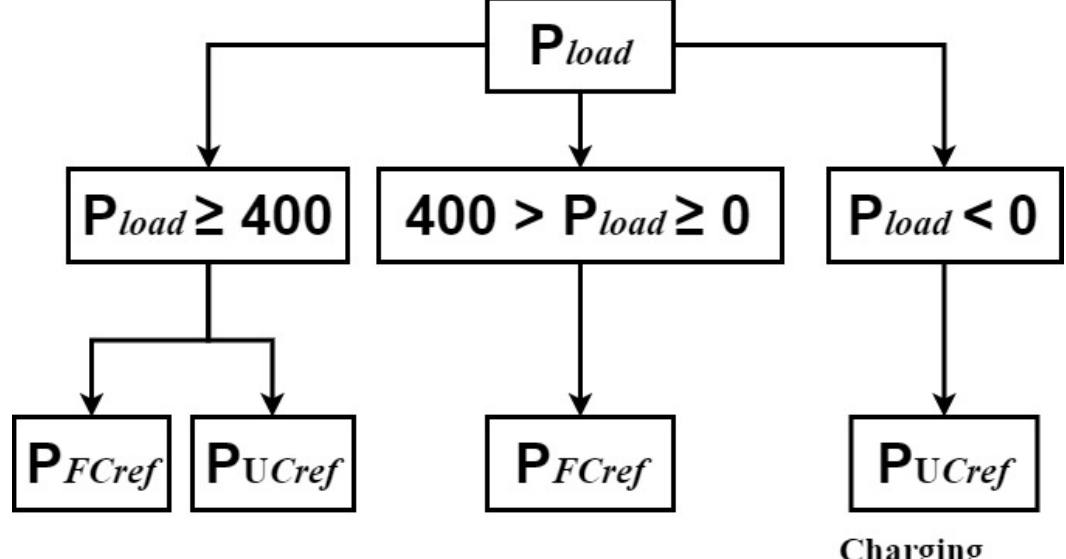
Figure 3. The power distribution strategy of the